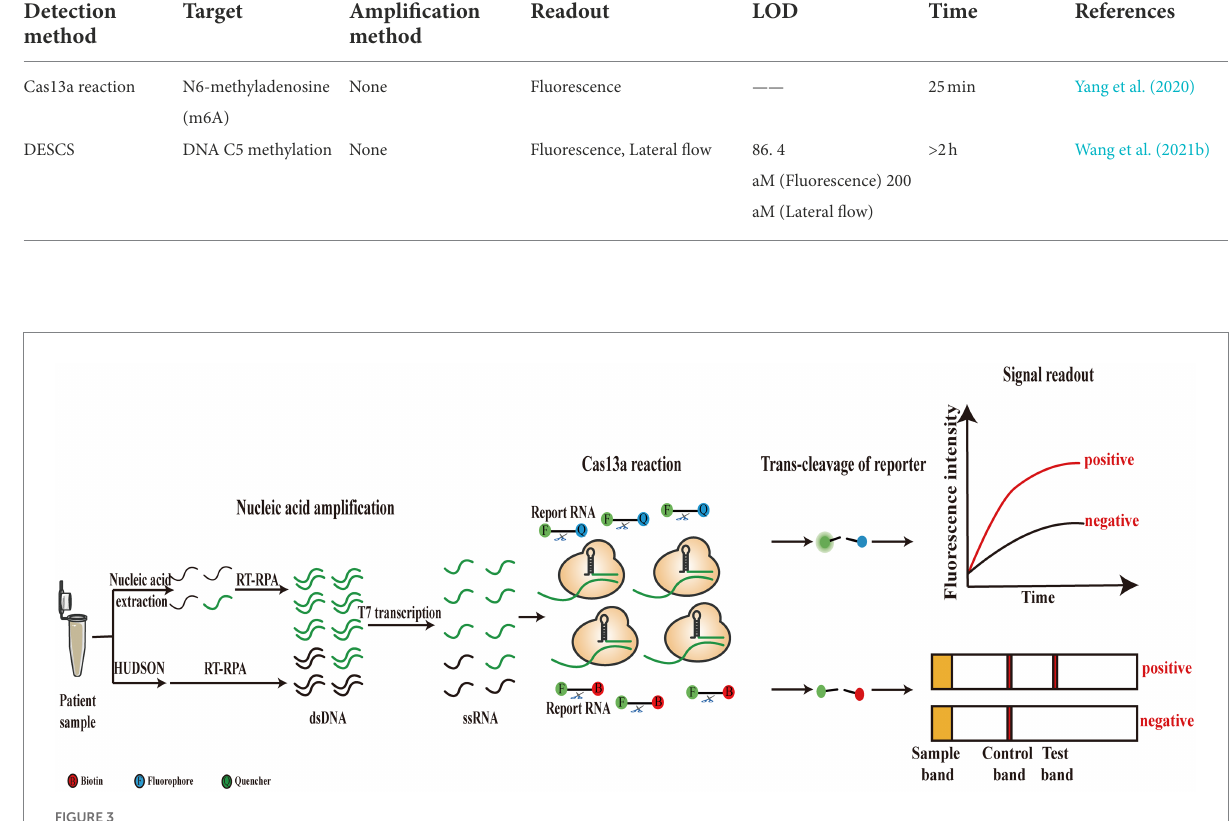
FIGURE 3 Schematic of original SHERLOCK and its improved versions. Target RNAs are extracted from patient sample and then amplified through RT-RPA and T7 transcription. Subsequently, amplification products are recognized and trans-cleaved by Cas13a system with fluorescence or lateral flow readout. Patient sample can also be directly treated by HUDSON method without the extraction